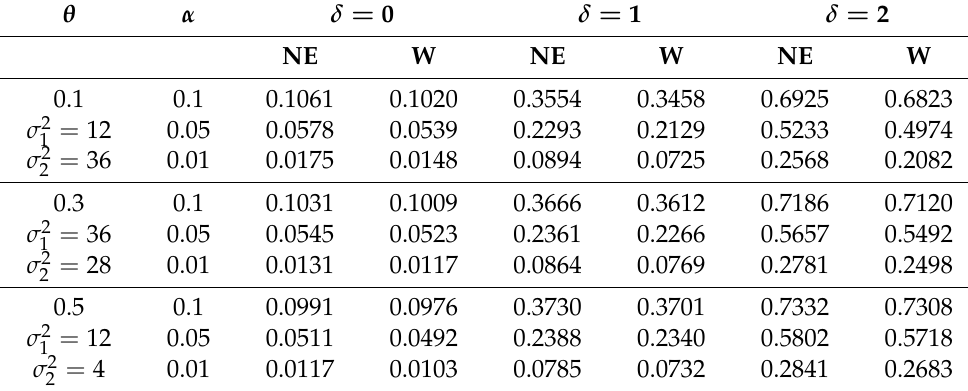
Table 4. Power values for ( n 1 , n 2 ) = ( 12,4 )